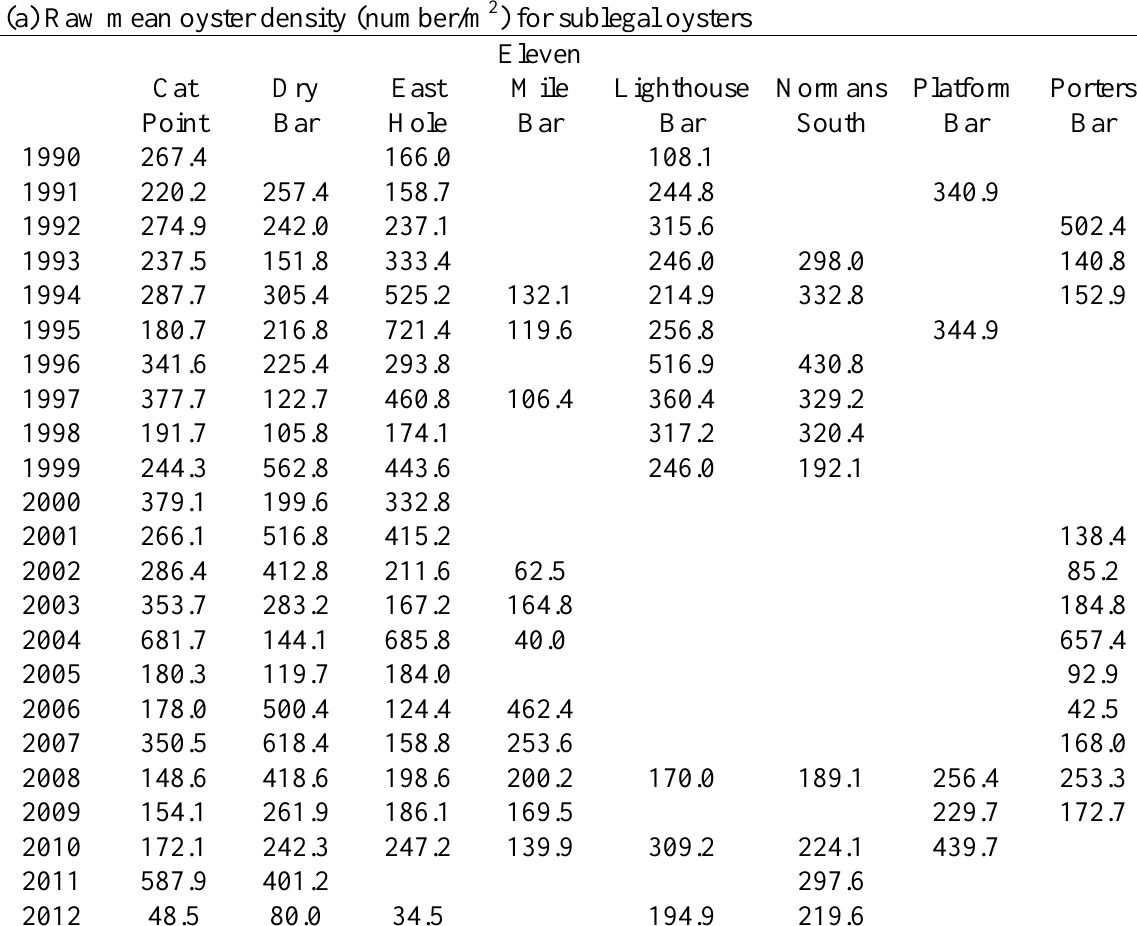
Table A2.2a-d. Estimates of raw and interpolated mean oyster density (number/m 2 ) for sublegal (20-75 mm shell length) and legal (> 75 mm) oysters from Florida Department of Agriculture and Consumer Services surveys on major oyster bars in Apalachicola